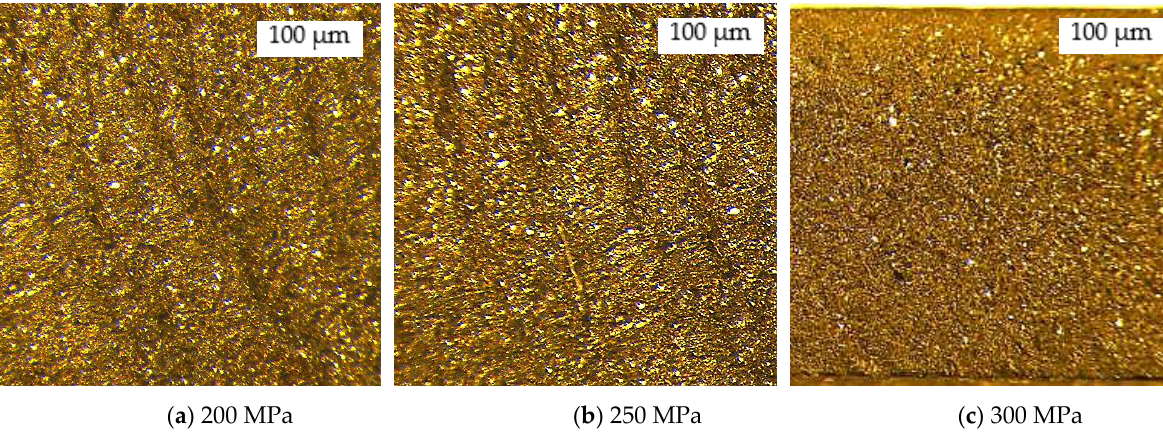
Figure 7. Topography of AISI 304L cut surface with 4 mm thickness using varied waterjet pressure.